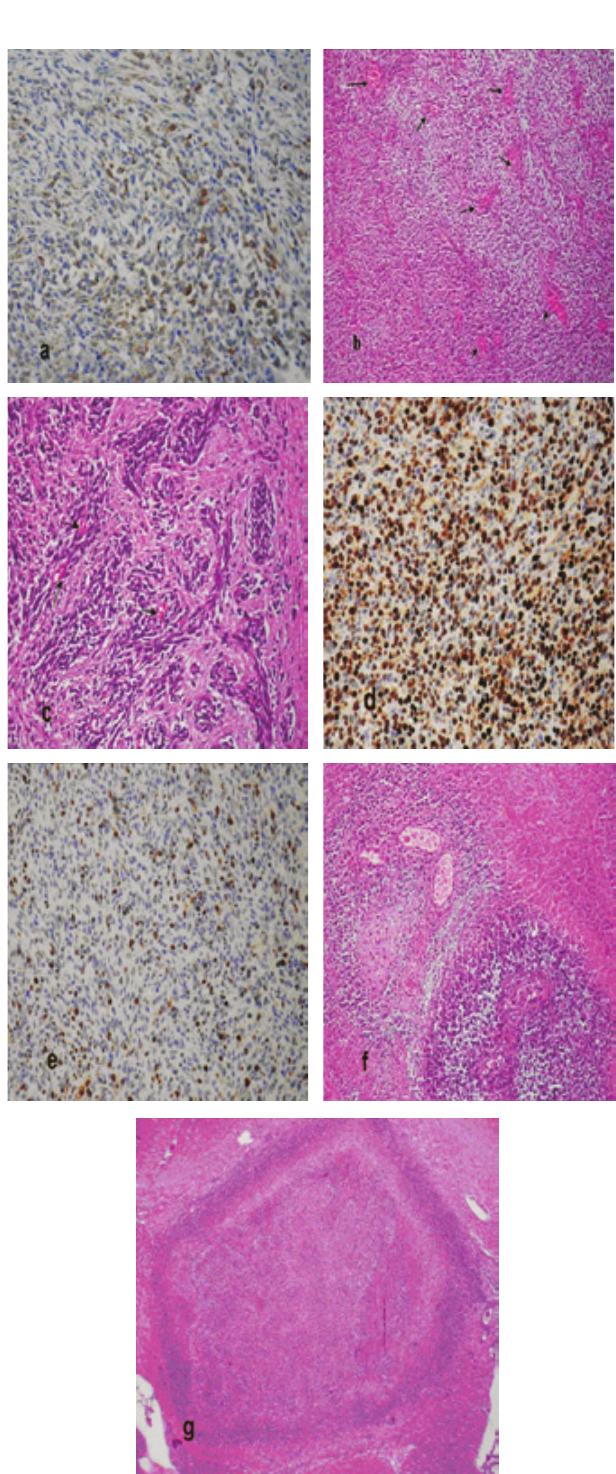
FIGURE 1 - (a) Immunohistochemically, the neoplastic cells react positively for GFAP (100x). (b) Intense vascular endothelial proliferation in Temozolomide (TMZ) treated group (arrows) (H&E, 200x). (c) Mild vascular endothelial proliferation in TMZ treated group (arrows) (H&E, 200x). (d) Glioma cell proliferation in control group was assessed by immunostaining for Ki67 intense positive glioma cell nuclei (200x). (e) In combination TMZ and HBO was stained Ki67 mild positive (200x). (f) Mild Necrosis with pseudopalisading in group 3 (H&E, 200x). (g) Necrosis with pseudopalisading in control group (H&E,